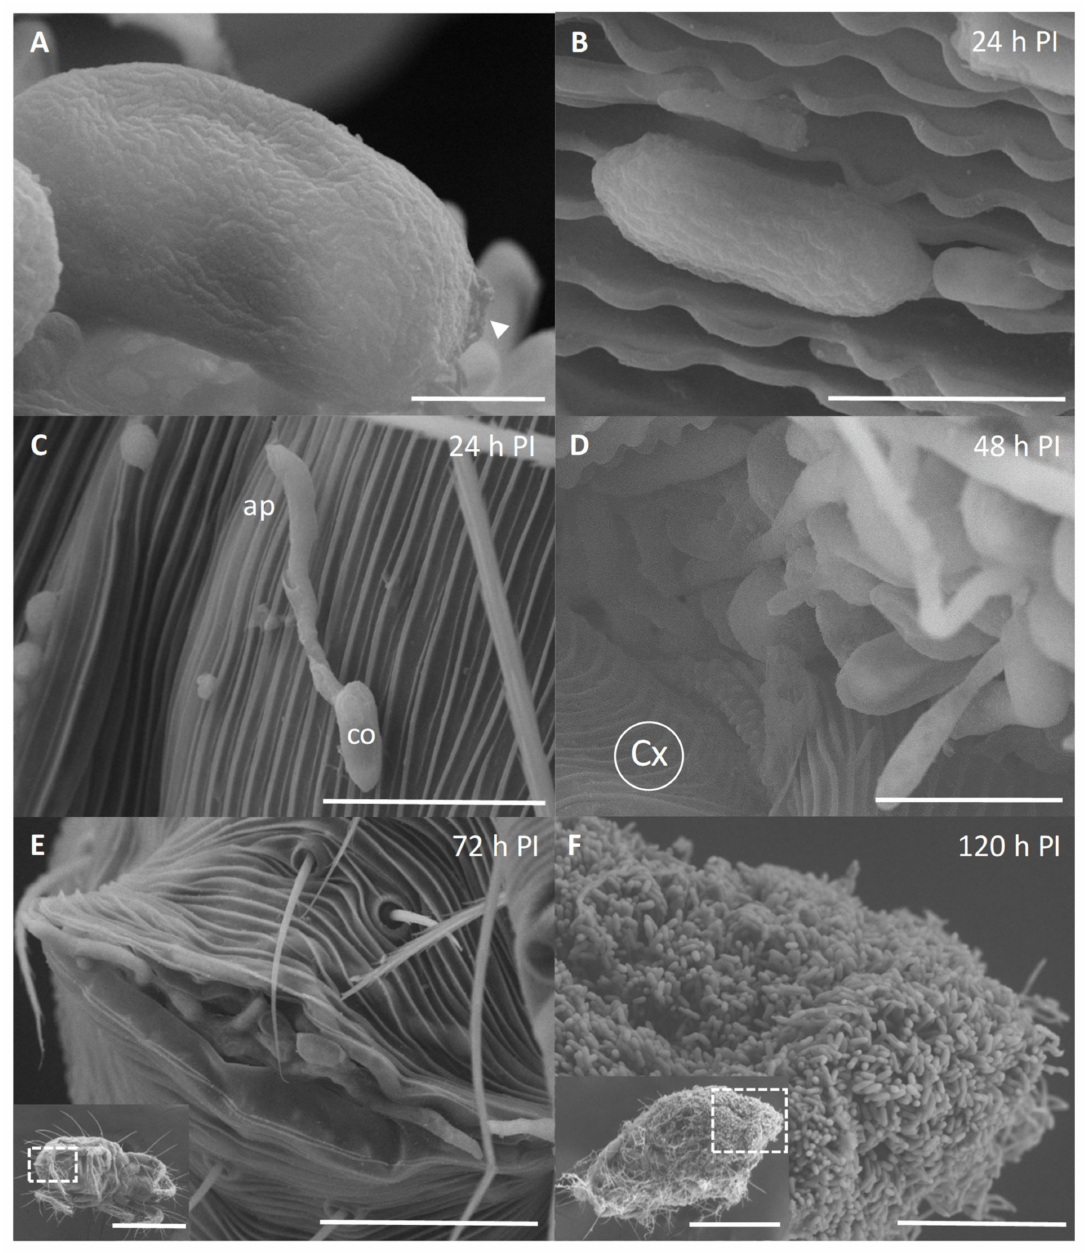
Figure 3. Scanning Electron micrographs of Metarhizium sp. BCC 4849 growing on a surface of cassava mites. ( A ) The arrangement of rodlet bundles on the surface of Metarhizium sp. BCC 4849 conidia. A conidial scar was seen after abstriction. Bar, 1 µ m. ( B ) A germinating conidium was embedded in the striae integumentary lobes of the mite cuticle. Bar, 3 µ m. ( C ) At 24 h PI, a germinating conidium (co) formed appressorium (ap) on the cuticle. Bar, 10 µ m. ( D ) Conidia and hyphae extensively grew and developed for penetration at the socket of coxa (Cx) at 48 h PI. Bar, 5 µ m. ( E ) At 72 h PI, fungal cells and hyphae extruded from the anal opening (indicated by the square in the inset; bar 200 µ m). Bar, 20 µ m. ( F ) Numerous conidia were present around the insect body, especially opisthosoma (indicated by the square in the inset; bar 200 µ m). Bar, 10 µ